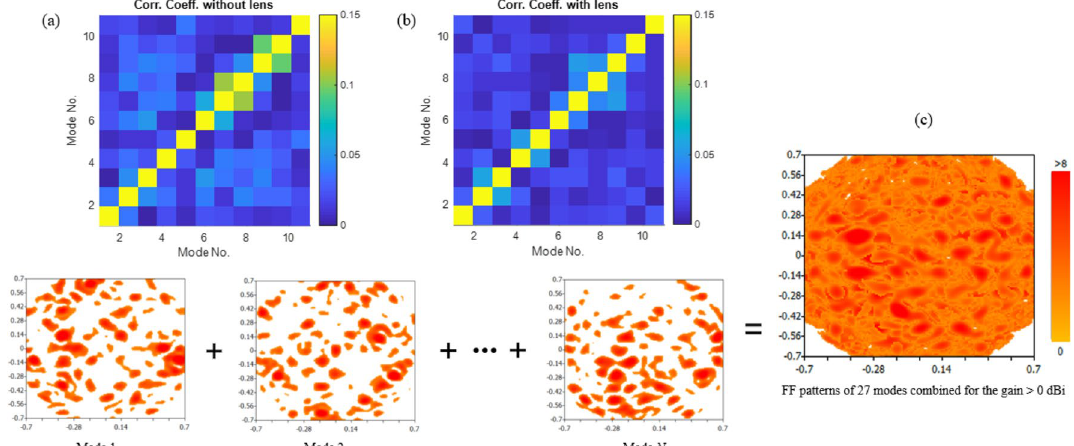
Figure 5. Correlation coefficient of 11 mode patterns ( a ) without lens and ( b ) with lens from 27.5 to 28.5 GHz. ( c ) Superposition of N individual mode patterns when the 2D contour plots are clamped for any value of the gain below 0 dB. Superposition of N = 21 modes show that the entire coverage of the forward half space FoV is possible using the lens-loaded cavity.